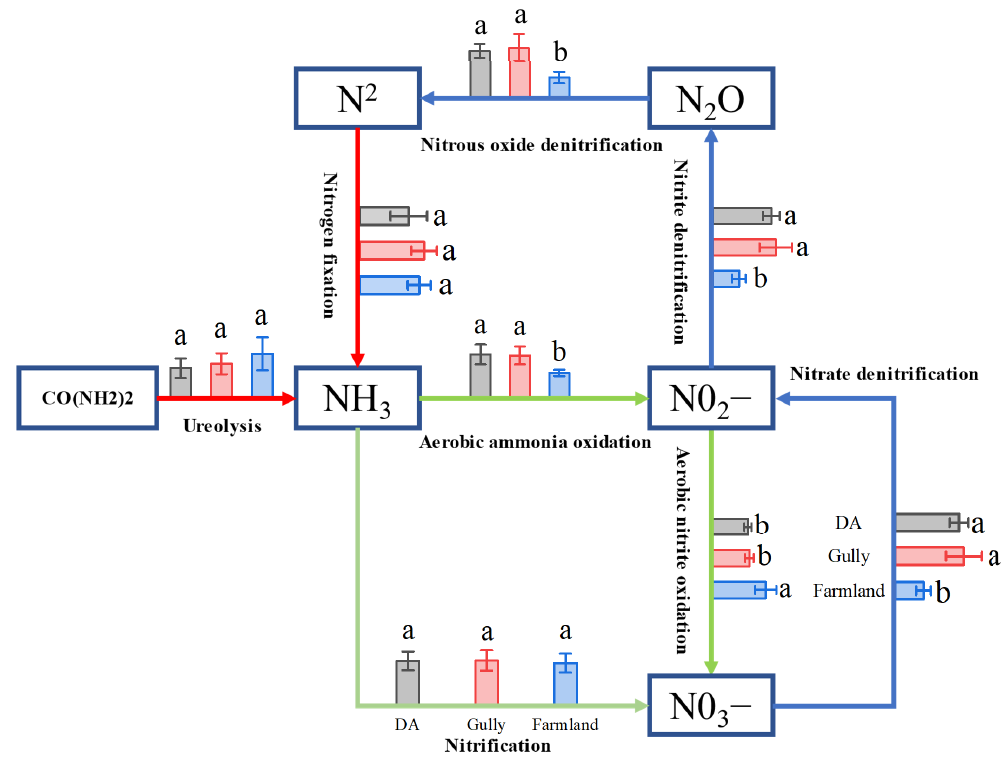
Figure 6. The microbial metabolic function groups of soil nitrogen cycling are differed among the farmland, gully, and deposition area. Error bars are twice of the standard error of the mean values. Mean values with the same lower case were no significant difference at p < 0.05 between farmland, gully, and deposition area (DA).